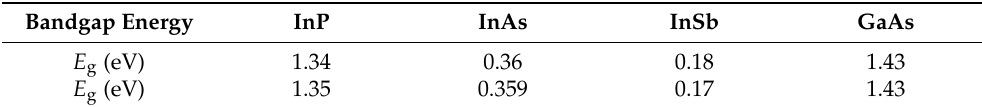
Table 2. E g values retrieved from the literature (first row Ref. [11], and second row Ref.